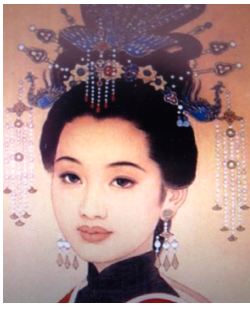
Figure 6. Chinese noblewoman.